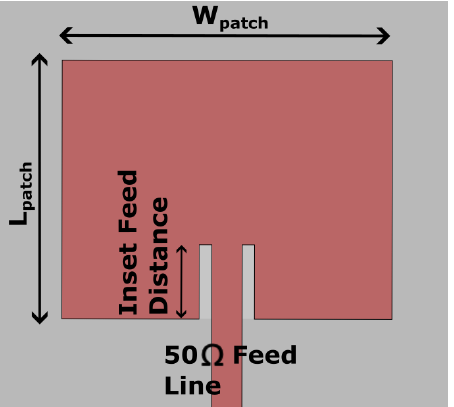
Figure 3. Rectangular microstrip patch antenna with a 50 Ω microstrip feed